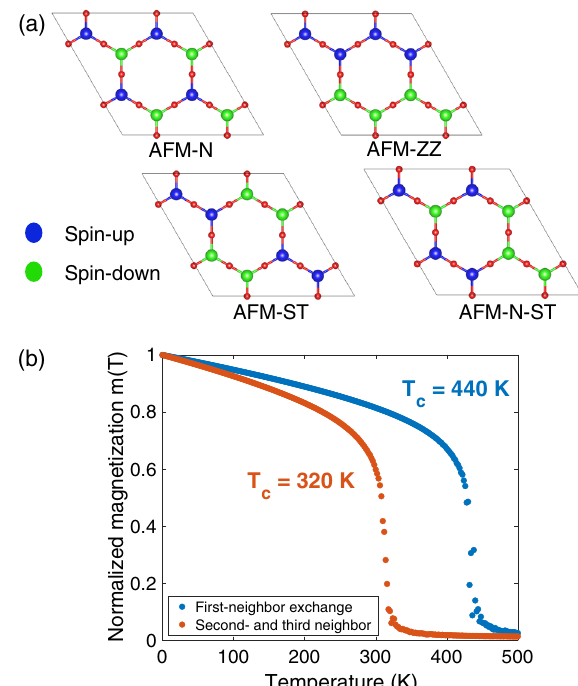
Fig. 2 Magnetic con fi gurations and Curie temperature. a Top view of various possible AFM con fi gurations. b The normalized magne- tization as a function of the temperature from the MC simulations indicating a T c = 440 K.